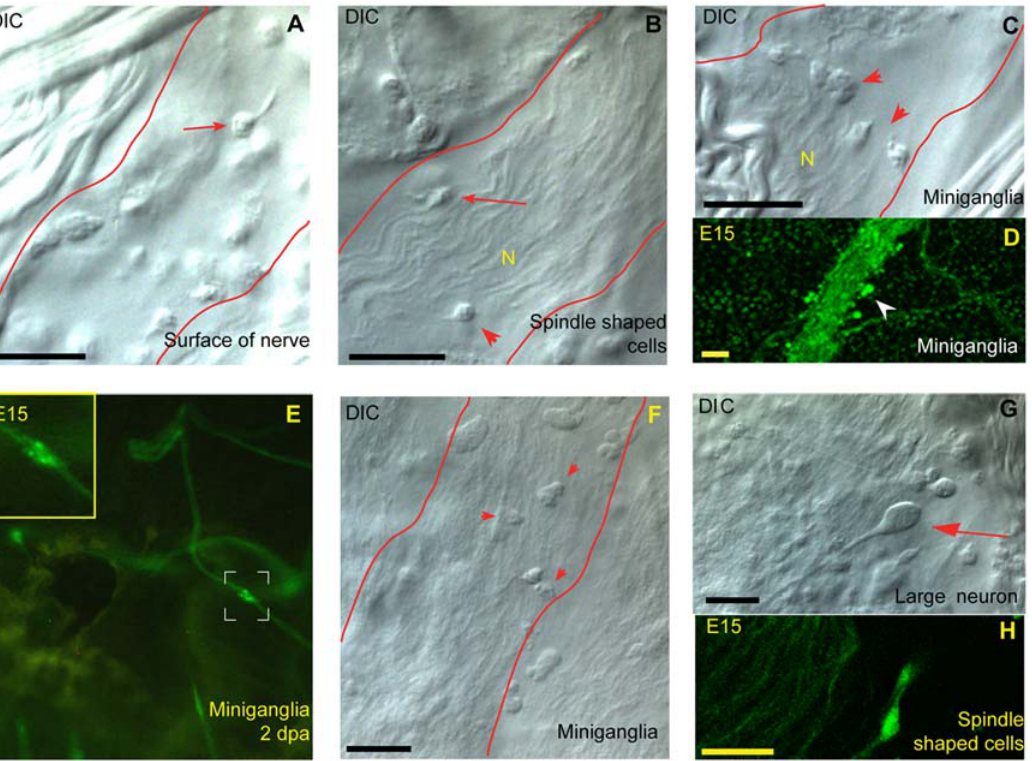
Figure 6. Nerve cell types found peripherally and ‘‘miniganglia’’. Neural cells located peripherally to the ganglion along the major nerves (red line indicating nerve tract). These are either small round cells with a clear neuritic extension (arrow in A ) or spindle-shaped cells (arrowhead in B ) integrated into the nerve fibre (N). The round cells are sometimes organized into ‘‘miniganglia’’ (arrowheads in C , D and E ). E shows a ‘‘miniganglion’’ soon after ablation (2 dpa, inset showing close-up). Other cells along the peripheral nerve (arrowheads in F ). G shows the different morphology of the larger motor neurons seen only in the ganglion (arrow). H shows some of the spindle-shaped cells in the area just adjacent to the ganglion. Scale bars, 20 m m. Fluorescent confocal images obtained with the Leica SP5 system and DIC images obtained with the Leica DMRBE compound microscope (40 6 ).